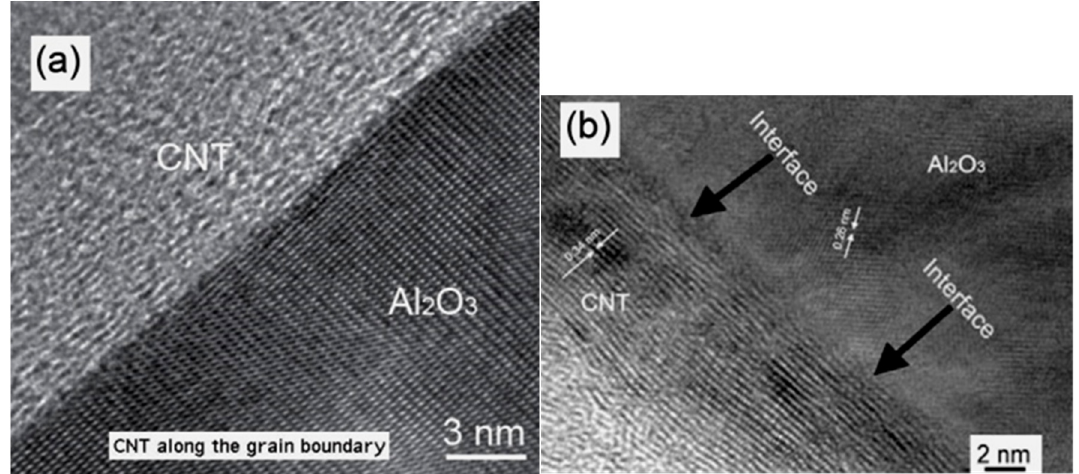
Figure 4. ( a , b ) High-resolution TEM images showing CNT/ceramic interfaces.